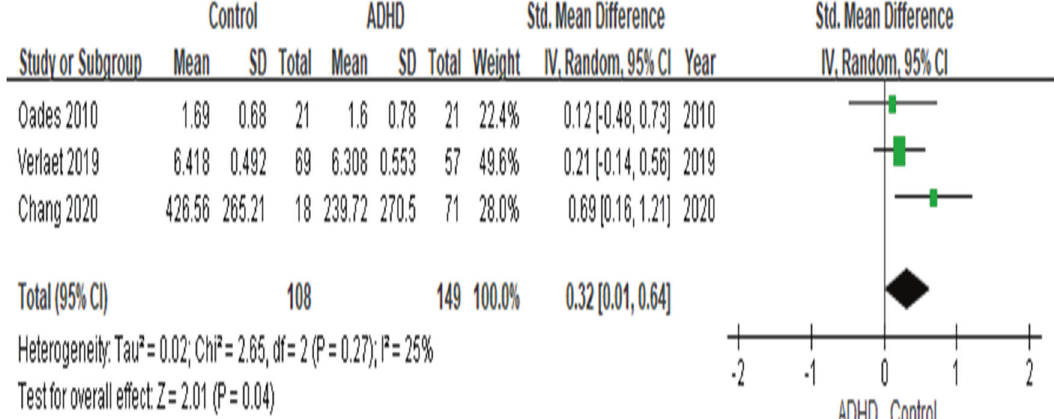
Fig. 3 Forest plots comparing effect sizes of TNF- α levels between ADHD and TD groups. Forest plots showing effect sizes (Hedges ’ s g) and 95% con fi dence intervals (CIs) from individual studies and pooled results comparing TNF- α levels between ADHD population and TD group. Note, ADHD, attention de fi cit hyperactivity disorder, CI con fi dence interval, Std standard, TD typically developing youth, TNF- α tumour necrosis